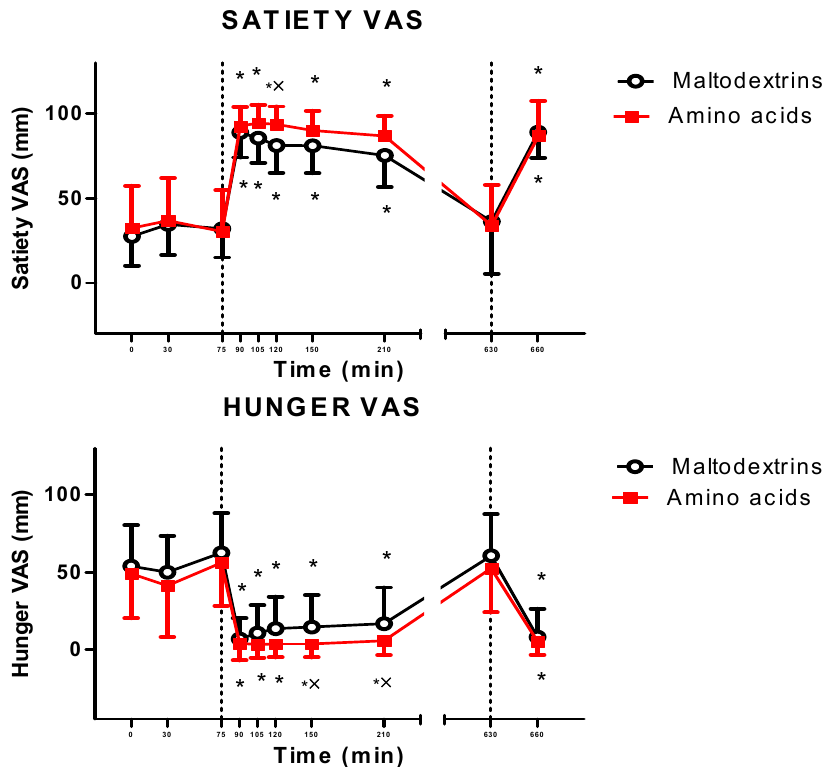
Figure 3. Changes in VAS ratings of satiety (top panel) and hunger (bottom panel) in obese adolescents after a fixed-dose lunch (completely consumed within 15 min starting at T75) or ad libitum dinner (within 20 min starting at T630), administered with amino acid mix (L-arginine, L-leucine, L-glutamine, and L-tryptophan) or placebo (maltodextrins) at T0 for the lunch test and at T555 for the dinner test. See the text for further details. Values are expressed as means ± SDs. The number of subjects was 14. * p < 0.05 vs. the corresponding T0 or T630 value; × p < 0.05 vs. the value in the maltodextrin-treated group at the corresponding time point. A two-way ANOVA with repeated measures (with the two factors time and group and the interaction time × group) followed by the post hoc Tukey’s test was used. The lunch significantly increased glucose and insulin levels (glucose: at T90, T105, T120, T150, and T210 vs. T0 for amino acids and at T30, T75, T90, T105, and T120 vs. T0 for